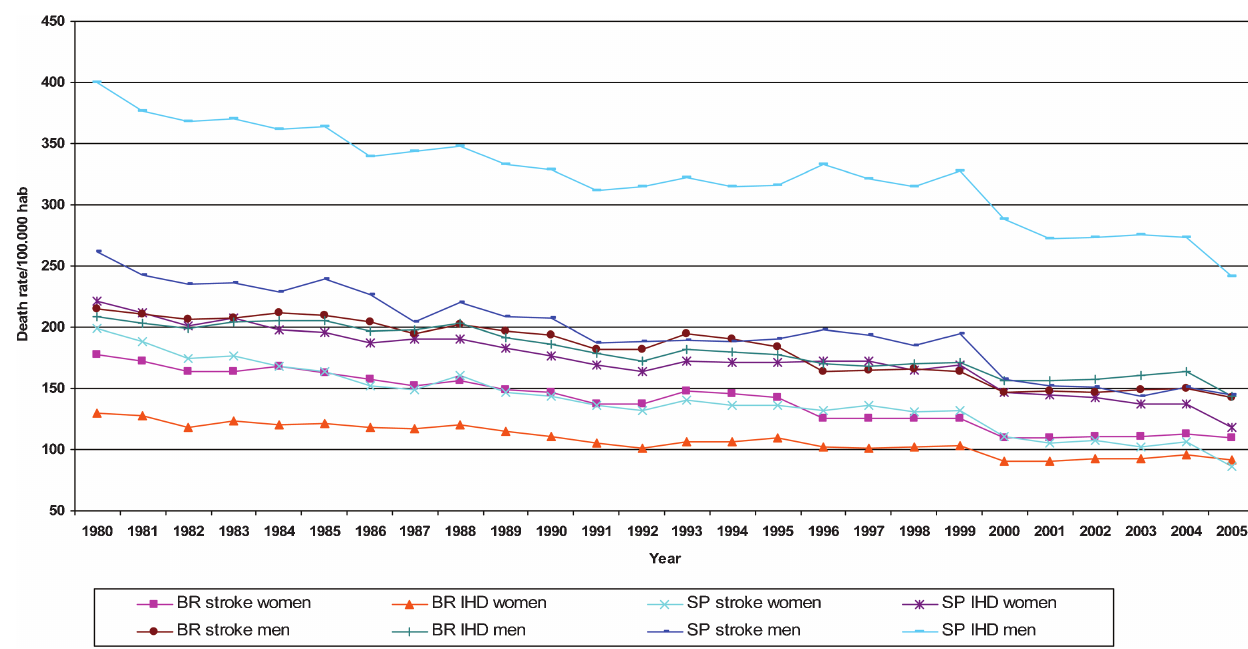
Figure 1 - Death rates associated with cardiovascular disease (CVD), ischemic heart disease (IHD), and